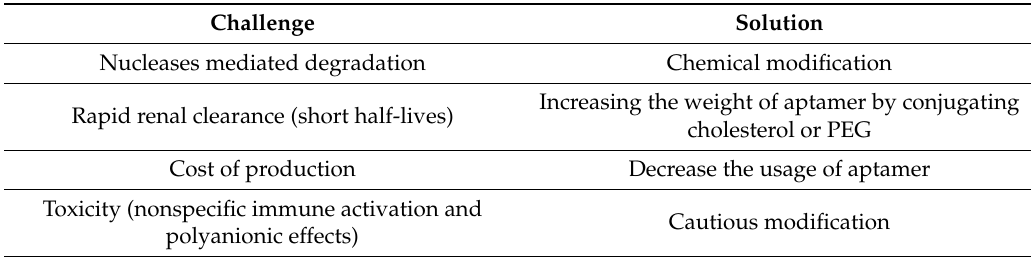
Table 4. Challenges of aptamer